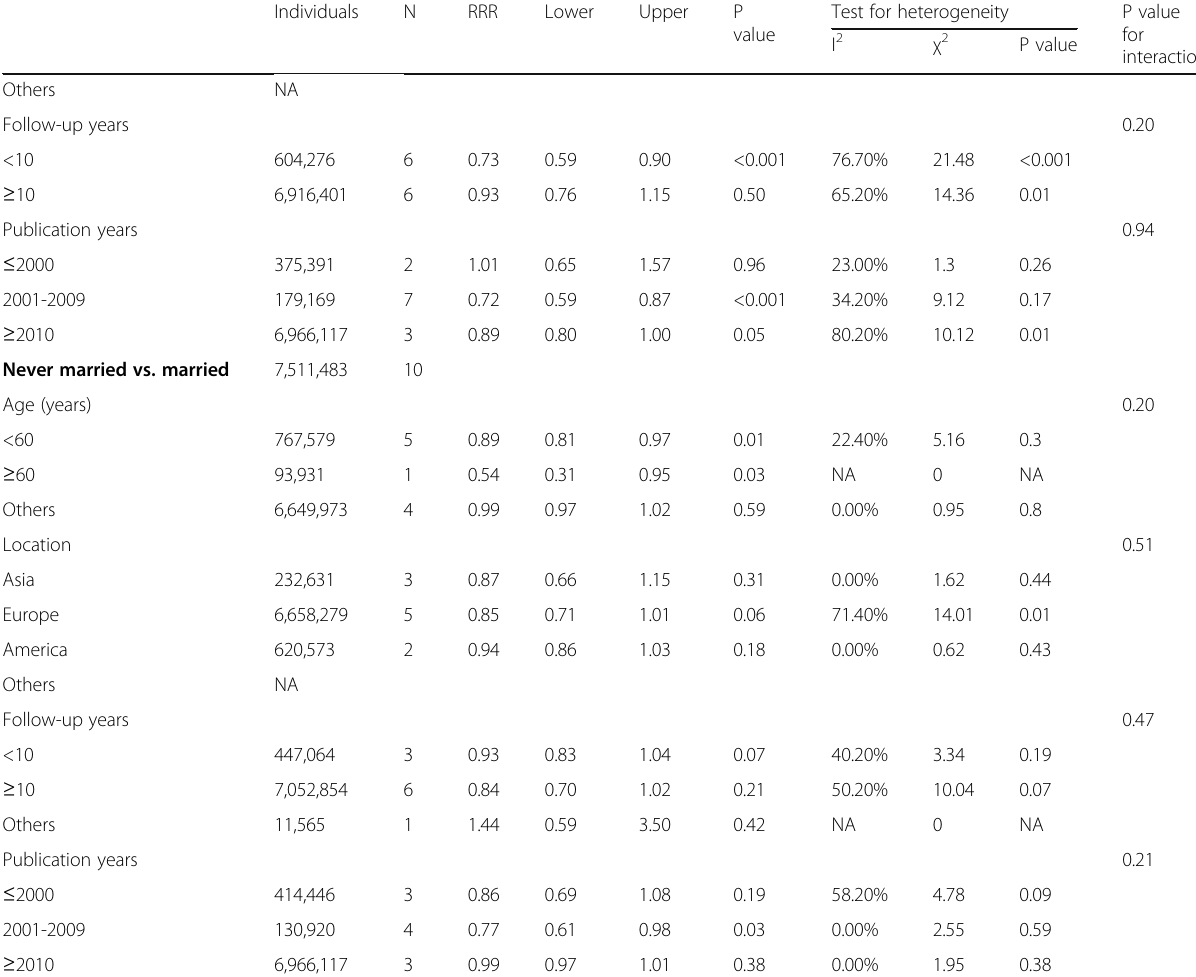
Table 2 Sensitivity analyses of women-to-men ratio of relative risks for all-cause mortality associated with marital status